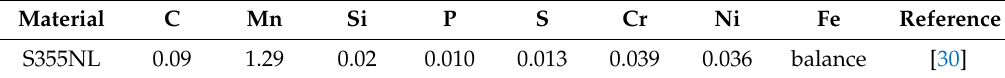
Table 2. Chemical composition of mild steel S355 in weight %.